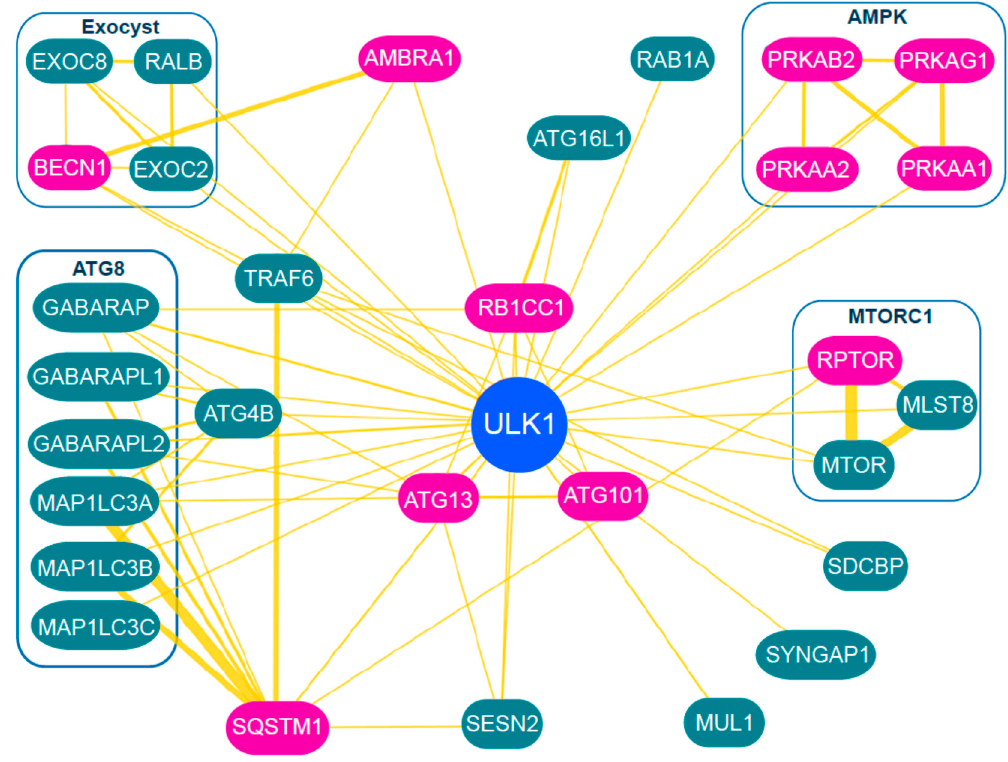
Figure 2. Summary of the ULK1 interactome . A subset of ULK1 protein interactions collated by the BioGRID server was selected for representation. Proteins characterised to also serve as ULK1 substrates are highlighted pink. Thickness of connectors corresponds to numbers of experimental entries supporting interaction. Note: this interaction database does not capture all known ULK1-binding partners including, for example, ATG9, ATG14L1 or FUNDC1.